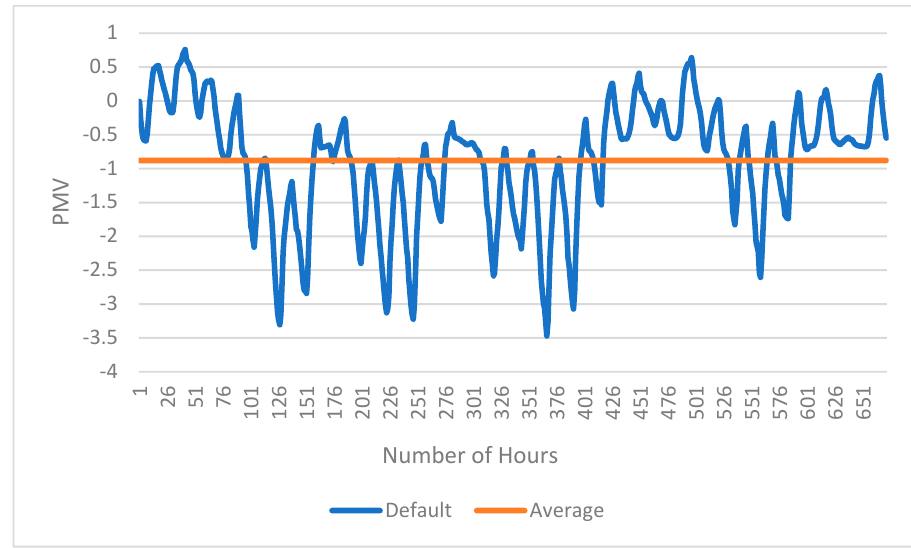
Figure 9. PMV fluctuation for occupant A in default simulation scenario.